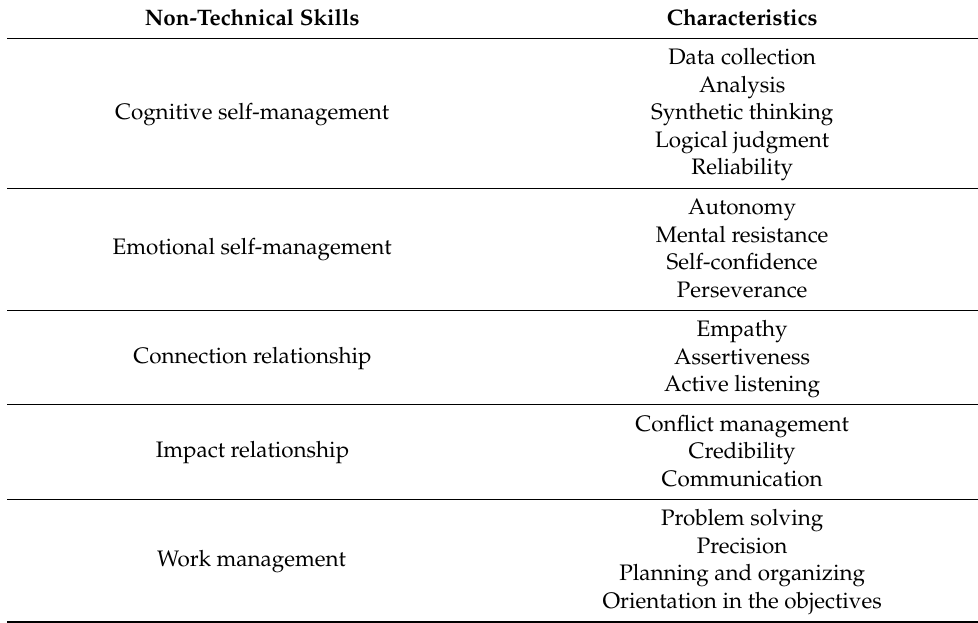
Table 1. Strategic non-technical skills